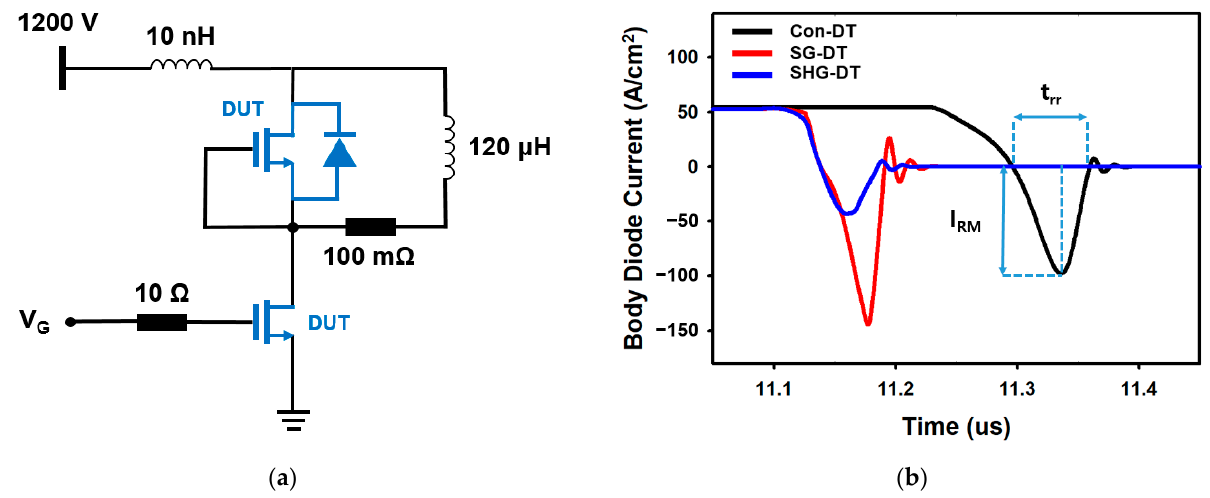
Figure 7. ( a ) Test circuit of reverse recovery charge and switching characteristics. ( b ) Comparison of body diodes reverse recovery characteristics of Con-DTMOS, SG-DTMOS, and SHG-DTMOS.